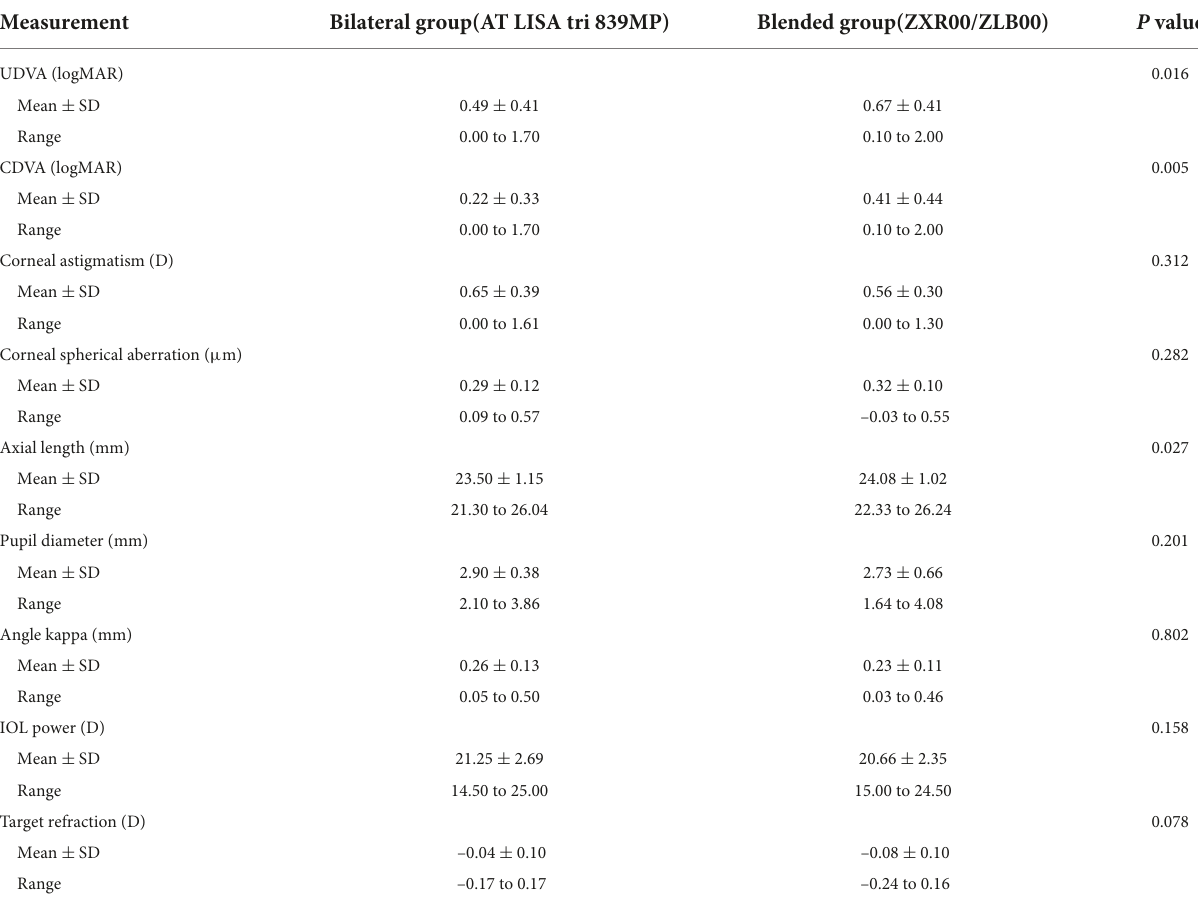
TABLE 1 Descriptive measures for preoperative ocular characteristics of bilateral and blended